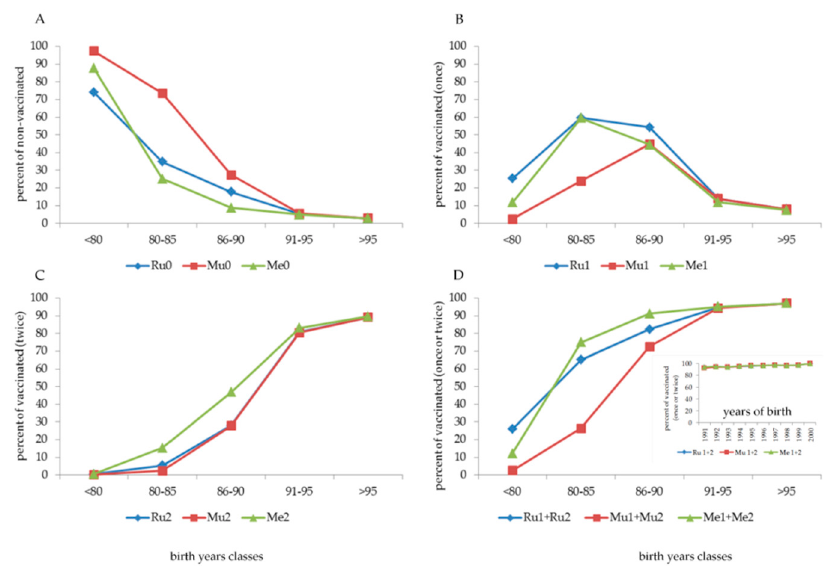
Figure 1. Percentage of subjects not vaccinated ( panel A ) or vaccinated with one ( panel B ), two ( panel C ) or one+two ( panel D ) doses according to date of birth classes. In the box at the bottom of panel D, the percentage of vaccinated subjects born between 1991 and 2000 with one+two doses is presented.